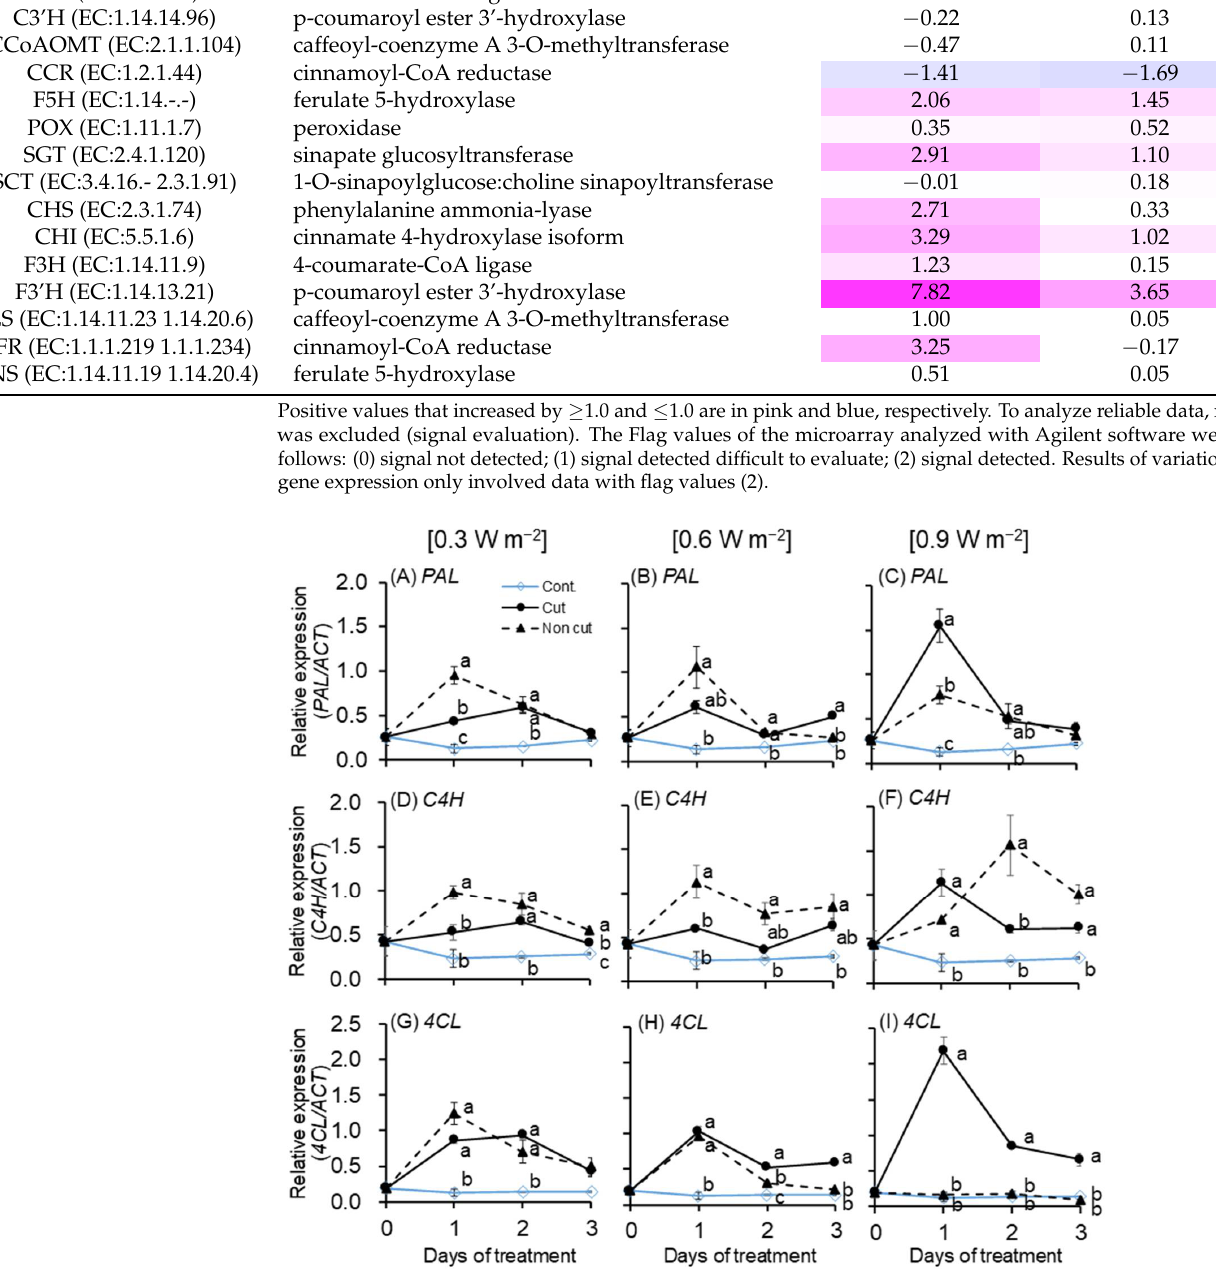
Figure 5. Gene expression of PAL ( A – C ), C4H ( D – F ), and 4CL ( G – I ) mRNA in the third leaf ( n = 3). The UV irradiation intensity was set at 0.3, 0.6, and 0.9 W m −2 . The vertical bars indicate SE ( n = 3). Different letters indicate significant differences among treatments in each UV irradiation intensity at p < 0.05 by Tukey–Kramer’s test.